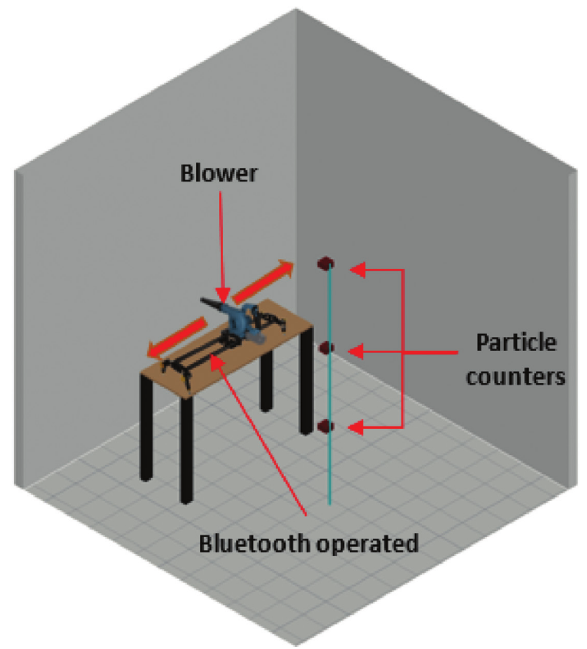
Schematic representation of the experimental setup and the movement of the blower inside the environmental chamber. (Source: Authors,